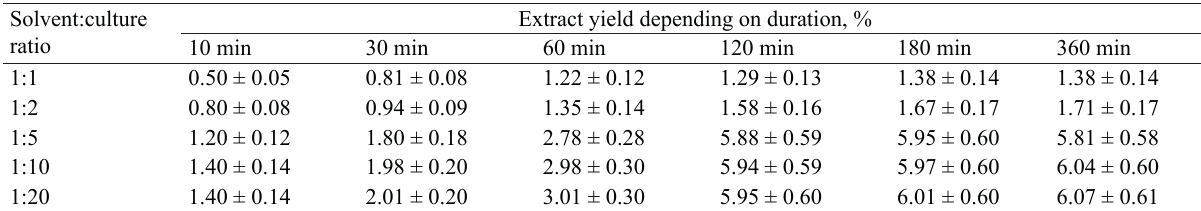
Table 1 Dry extract yield of biologically active substances from dried ginseng callus culture biomass depending on extraction time (at 45°C)